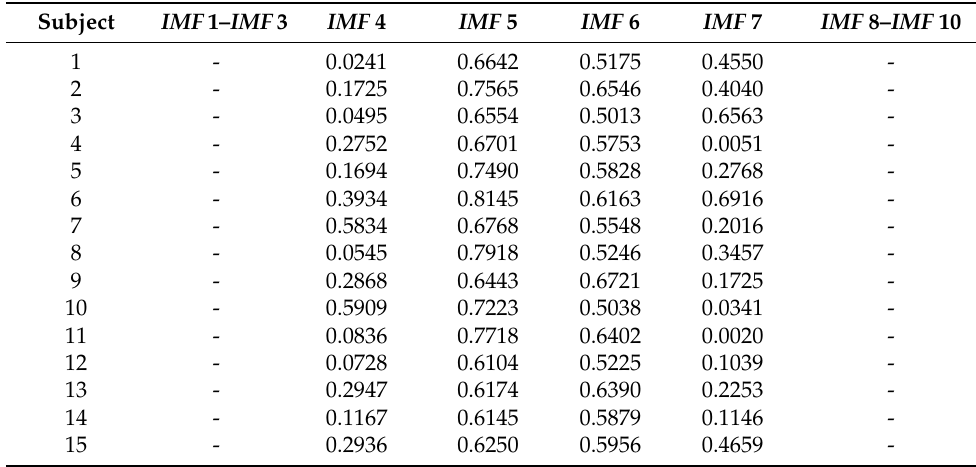
Figure 8. Fast time signal after clutter removal. Table 2. Calculated energy ratio for 15